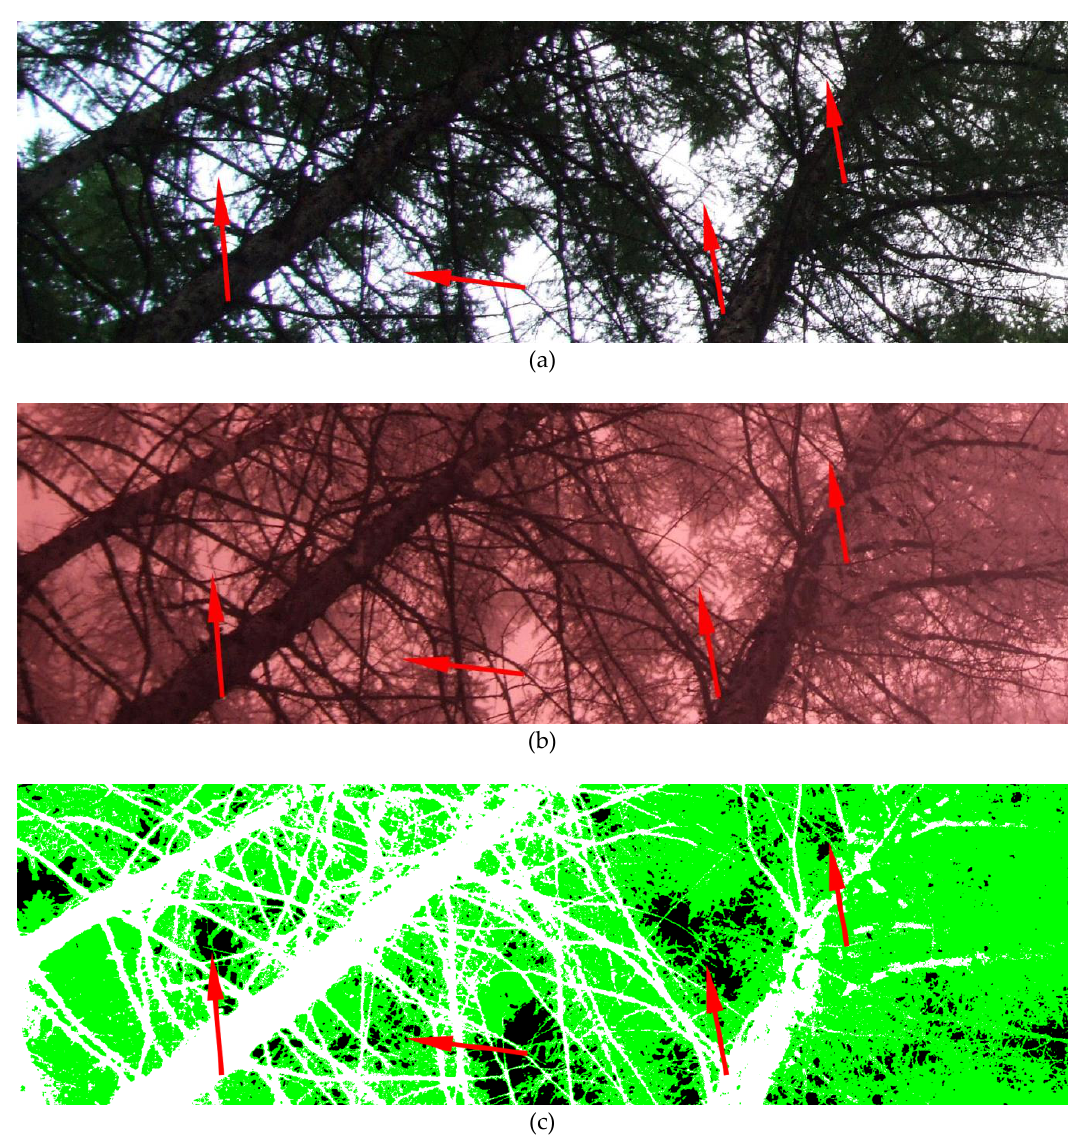
Figure 7. An example of the visible ( a ) and near-infrared ( b ) band images of one MCI image pair collected at one sampling point with azimuthal and zenith angles of 0° and 20° in plot 1, respectively (only half of the original images are shown here to improve the readership). Figure 7 c shows the corresponding classified MCI image of the MCI image pair.